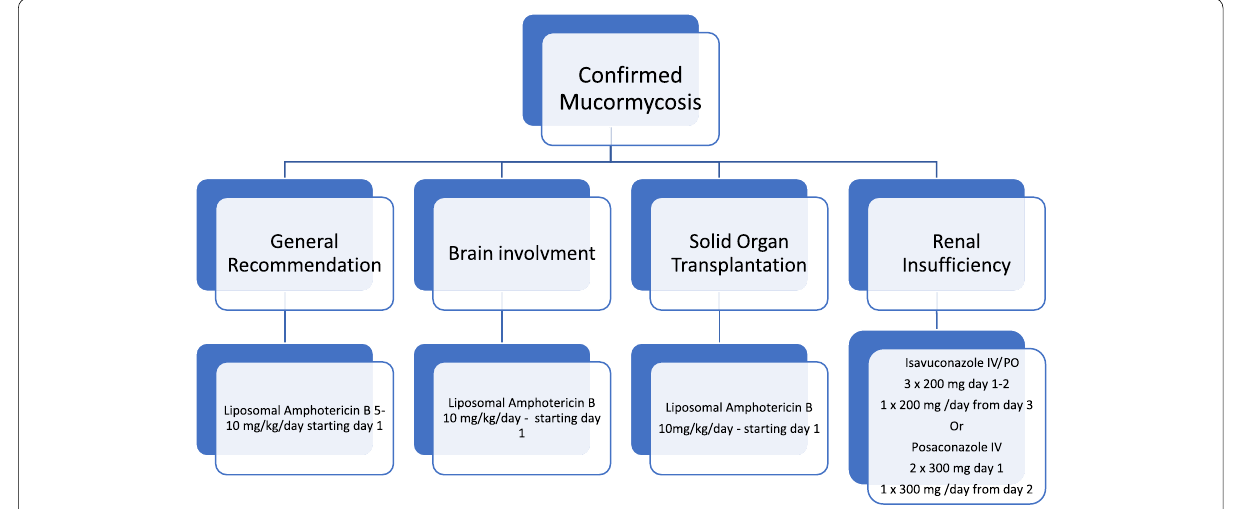
Fig. 2 Guideline recommended pharmacotherapy